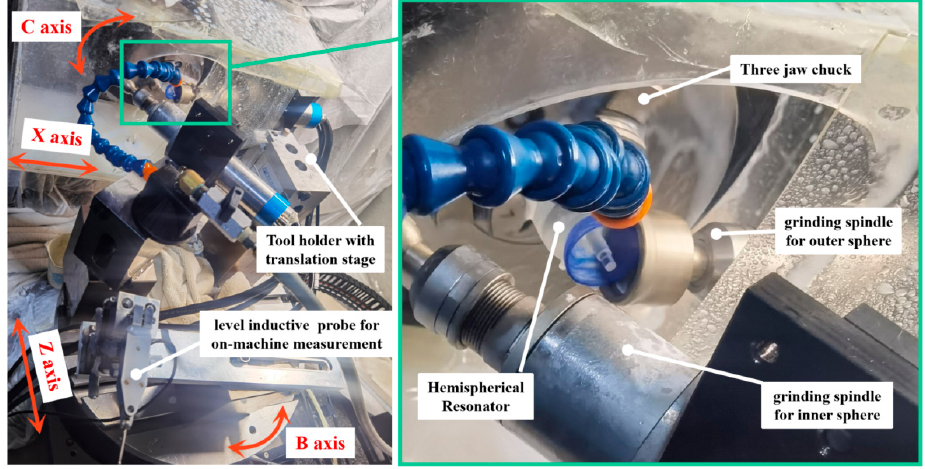
Figure 6. Hemispherical shell resonator grinding and on-machine measurement machine.